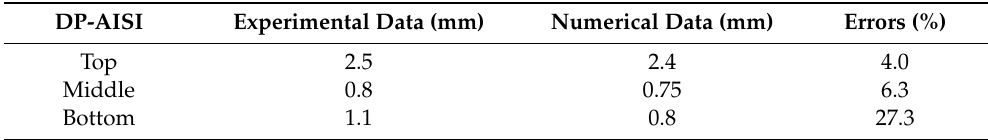
Table 5. Table of experimental and numerical dimensions of the DP-AISI fusion zone.